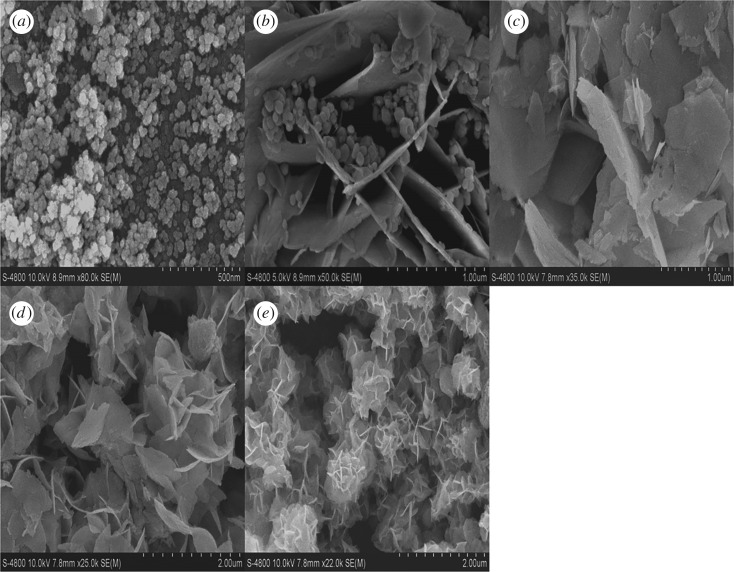
SEM images of EA:X samples: (a) H2O, (b) EA:1-1, (c) EA:2-1, (d) EA:5-1 and (e) EA:7-1.